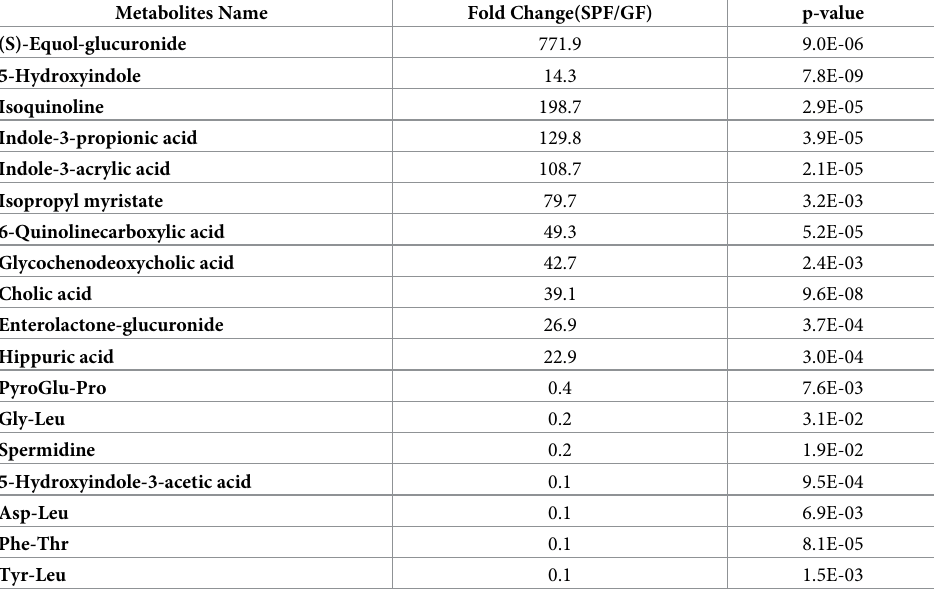
Table 4. Significantly transformed compounds in serum from 52 week-old ApoE -/- rats.